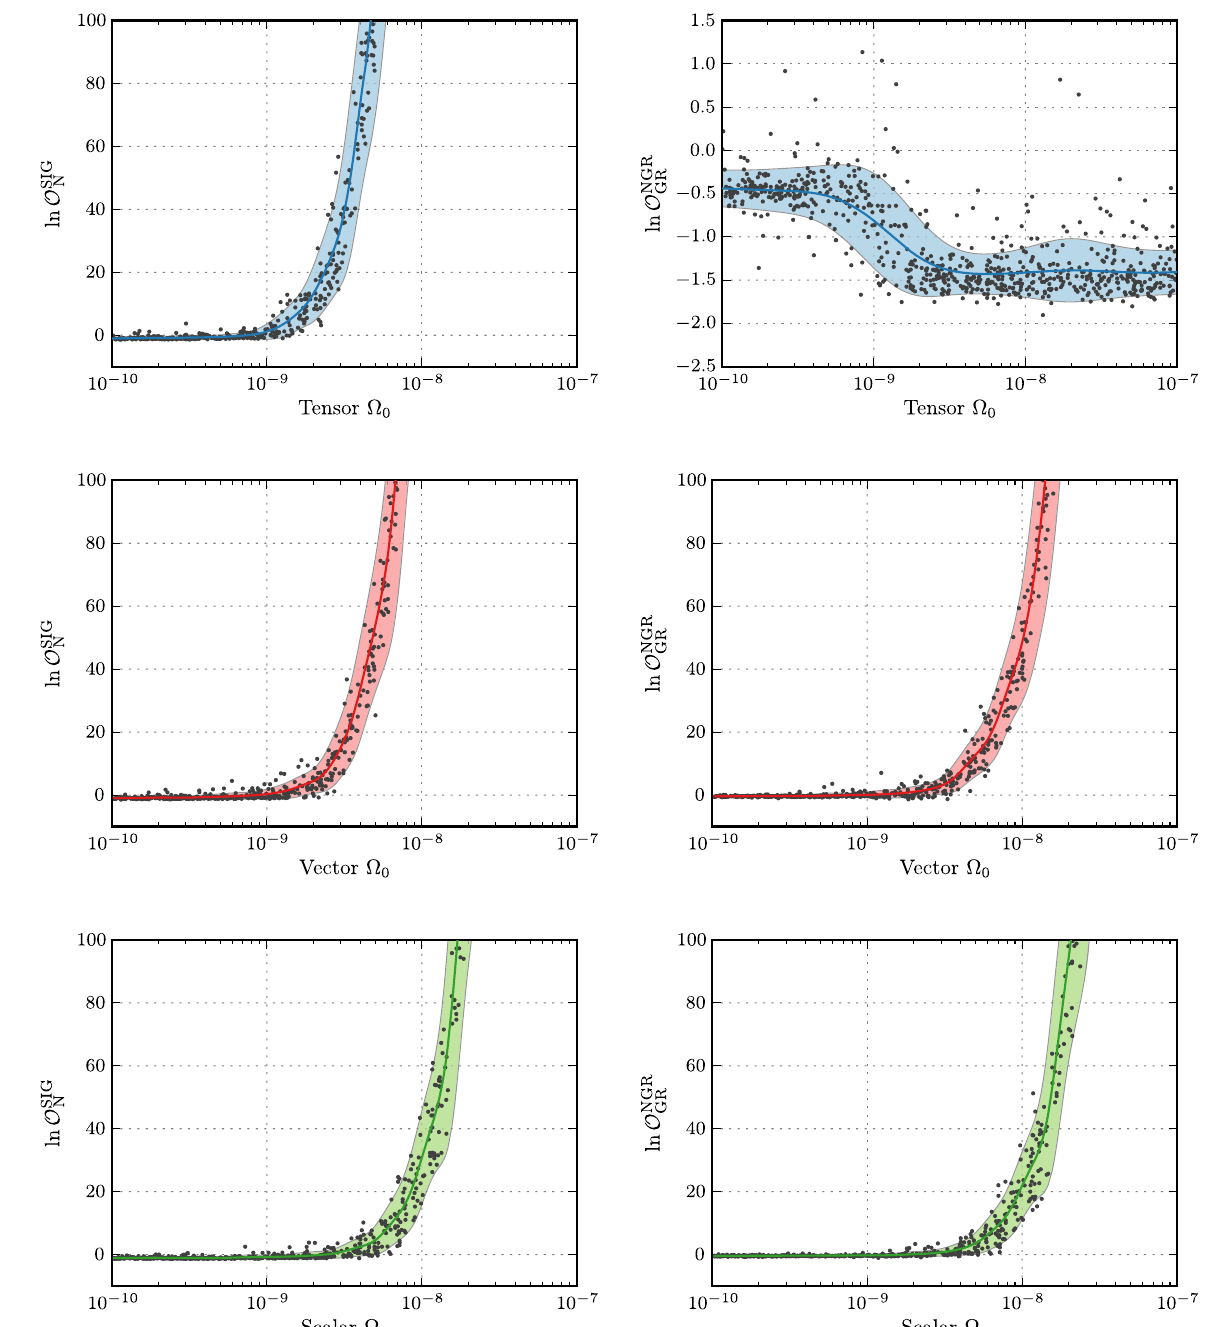
FIG. 7. Odds ratios O SIG (left) and O NGR (right) for simulated Advanced LIGO observations of purely tensor- (blue), vector- (red), and N GR scalar-polarized (green) stochastic backgrounds. Within each plot, we show 750 simulated observations, with random log amplitudes chosen uniformly over the range − 10 < log Ω 0 < − 7 . Black points mark the results from individual realizations, while the solid curves and shaded regions show the moving mean and standard deviations (smoothed with a Gaussian kernel) of these realizations. For each polarization, ln O SIG scales quadratically with the amplitude of the stochastic background. Similarly, ln O NGR scales quadratically with N GR vector and scalar amplitude. For tensor backgrounds, however, ln O NGR instead saturates at approximately − 1 . 4 GR (log Ω T 0 ≳ − 9 . 0 ), the recovered odds ratios decrease to when Ω S 0 is large, the scalar component is detectable and ≈ − 1 . 4 . This corresponds to the detection of the the recovered ln O NGR ln O NGR increases rapidly to large, positive GR GR tensor component alone; the decrease in odds ratios is the values. The threshold value of Ω S 0 at which ln O NGR GR same behavior previously seen in Figs. 6 and 7. Finally, becomes positive shows only little dependence on the